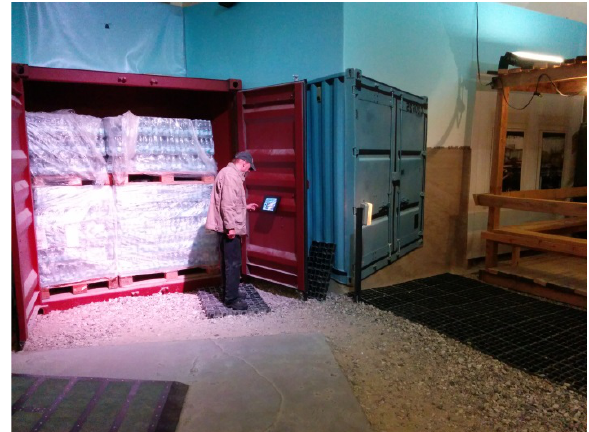
Figure 5. Information about life in a Danish military camp in Afghanistan is acquired by selecting short videos on a mounted iPad. Tøjhusmuseet,